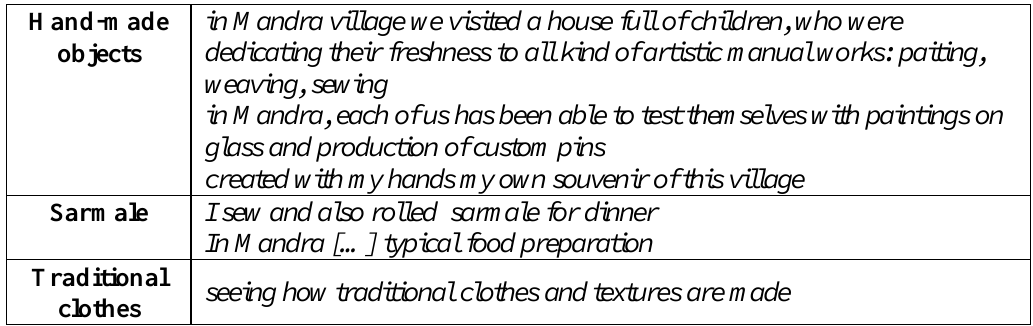
Table 6: Description of Touch/Haptic